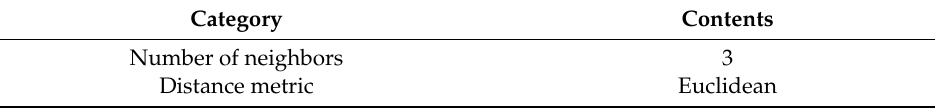
Table 7. Parameter configuration of KNN